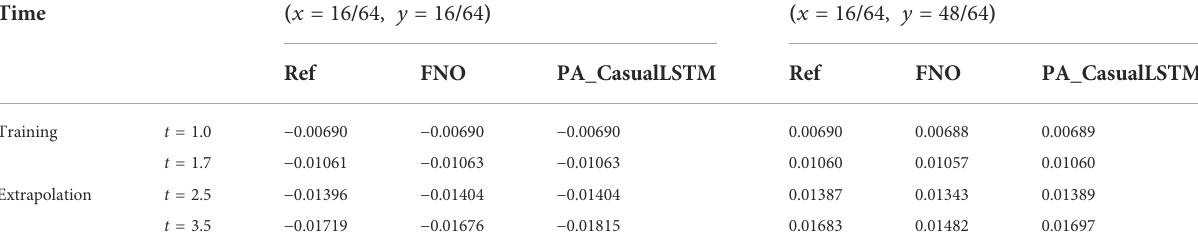
TABLE 3 Numerical results of velocity ( u ) for 2D Navier – Stokes equations solved by the classical numerical method, FNO, and